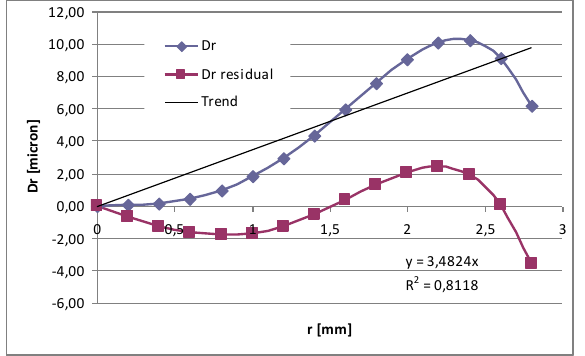
Figure 3 - Radial lens distortion resulting from Samsung S4 calibration